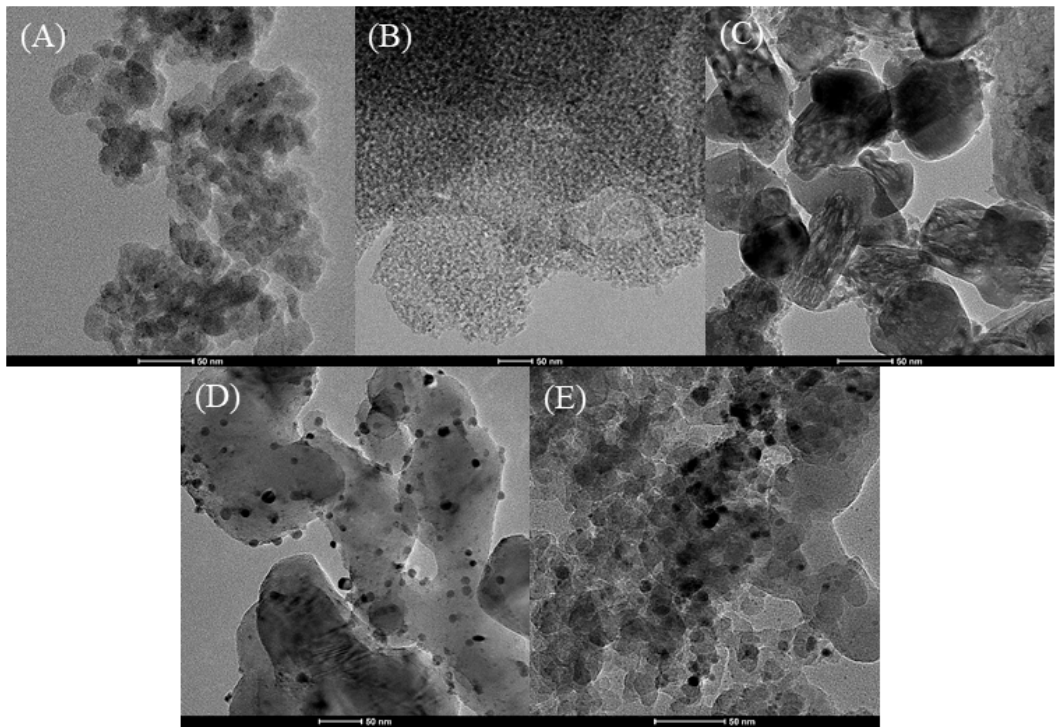
Figure 2. TEM micrographs of 2Pd- β ( A ), 2Pd-Al 2 O 3 ( B ), 2Pd-Fe 2 O 3 ( C ), 2Pd-MgO ( D ), and 2Pd-SiO 2 ( E ) catalysts.